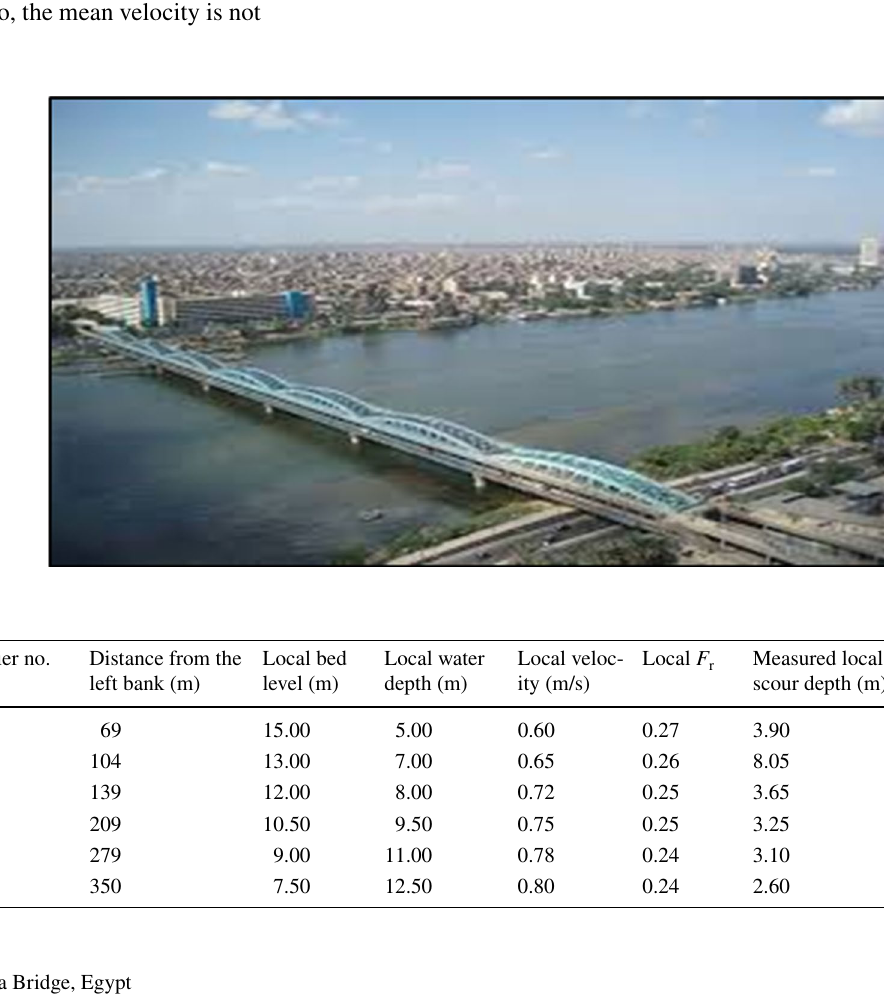
Table 4 Predicted local scour at Imbaba Bridge, Egypt Pier